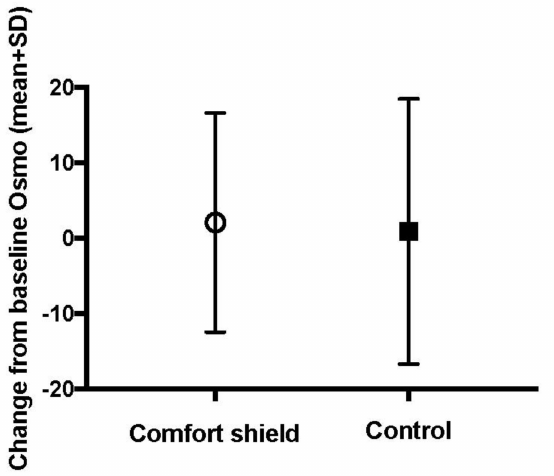
Figure A3. Mean ( ± SD) change from baseline to week 8 (week 8–baseline) of osmolarity by group—PPS ( n = 84). Open circle = Comfort Shield group, filled square = control